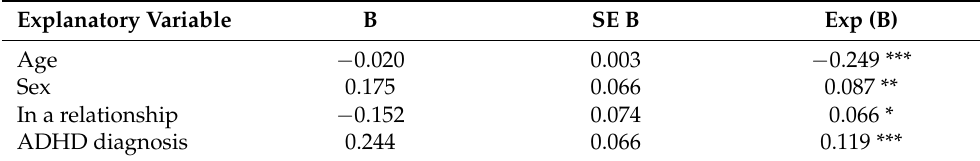
Table 8. Summary of final hierarchical regression analysis model for variables predicting extent of masturbation to